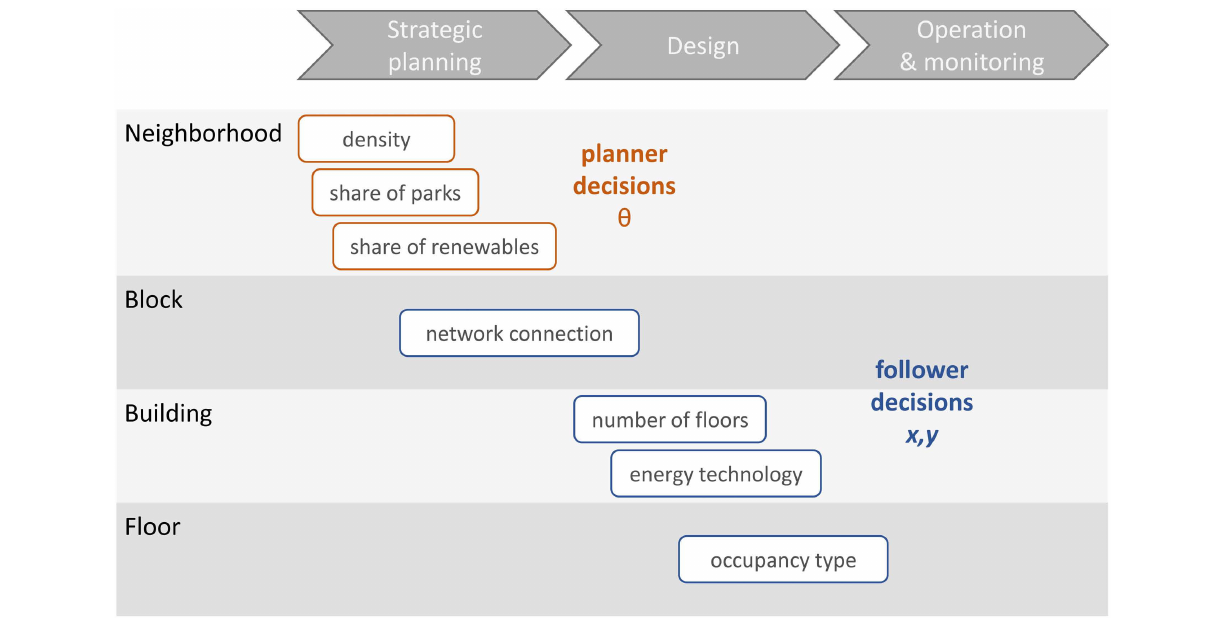
its bounds and interior tipping points (Scheffer et al., 2012)